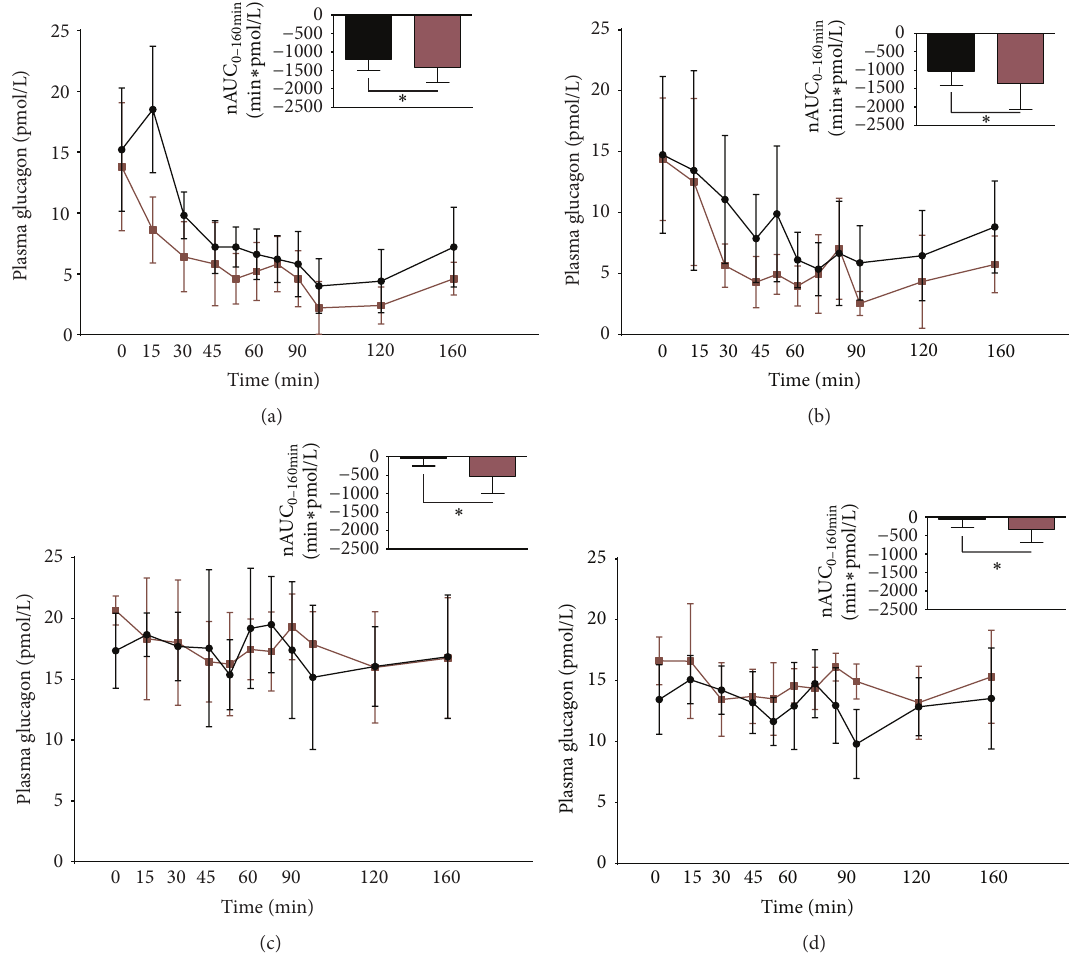
Figure 1: Plasma glucagon levels of five healthy participants during a 6mmol/L glucose clamp with simultaneous infusion of either saline (black) or atropine (red). (a) depicts assay A, a radioimmunoassay; (b) depicts assay B, a spectrophotometrically based ELISA; (c) depicts assay C, a chemiluminescence based ELISA; and (d) depicts assay D, a homogeneous time-resolved fluorescence based ELISA. Net area under the curve (nAUC) is depicted separately at upper right quadrant on (a), (b), (c), and (d). ∗ represents a significant two-sided 𝑡 -test comparing saline nAUC to atropine nAUC. Data illustrated as mean ± standard